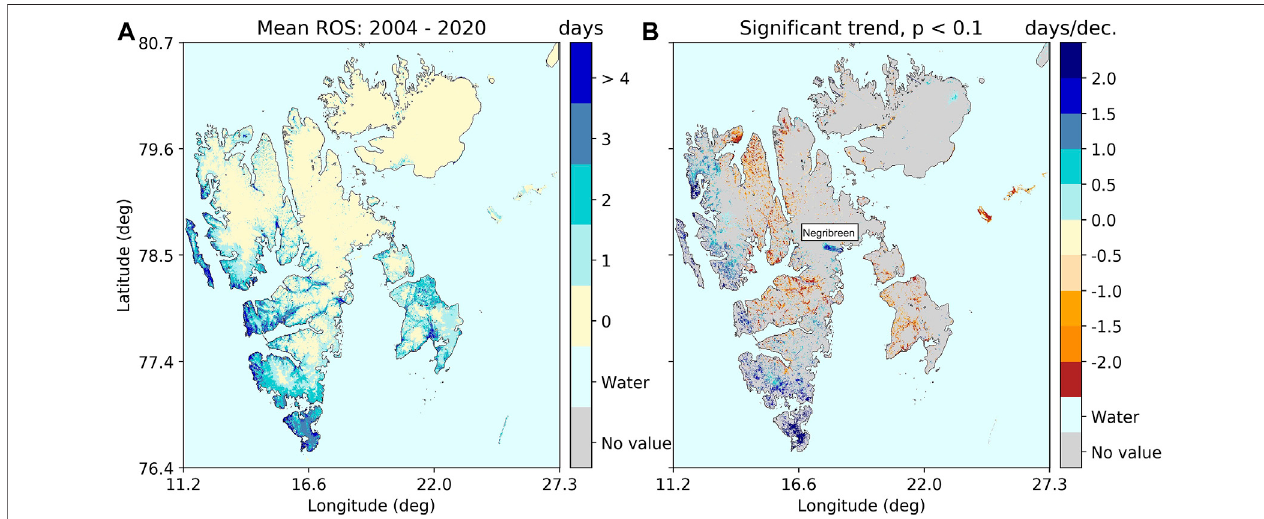
FIGURE 7 | (A) Map of the mean number of wintertime ROS events (1 November – April 30) detected in the period November 1 – April 30 for the winter seasons 2004 – 2020. (B) The linear trend in ROS frequency shown for only grid cells where the trend was statistically signi fi cant ( p <